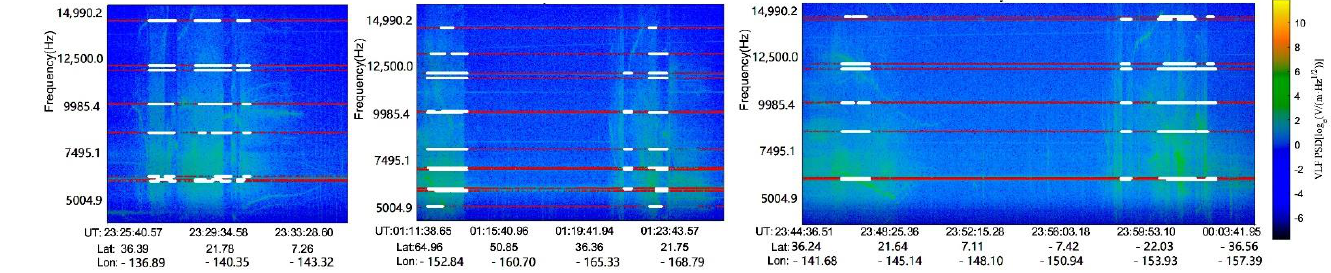
Figure 8. The automatic detection results of multiple abnormal disturbances are marked with white straight lines, Dis = 15.